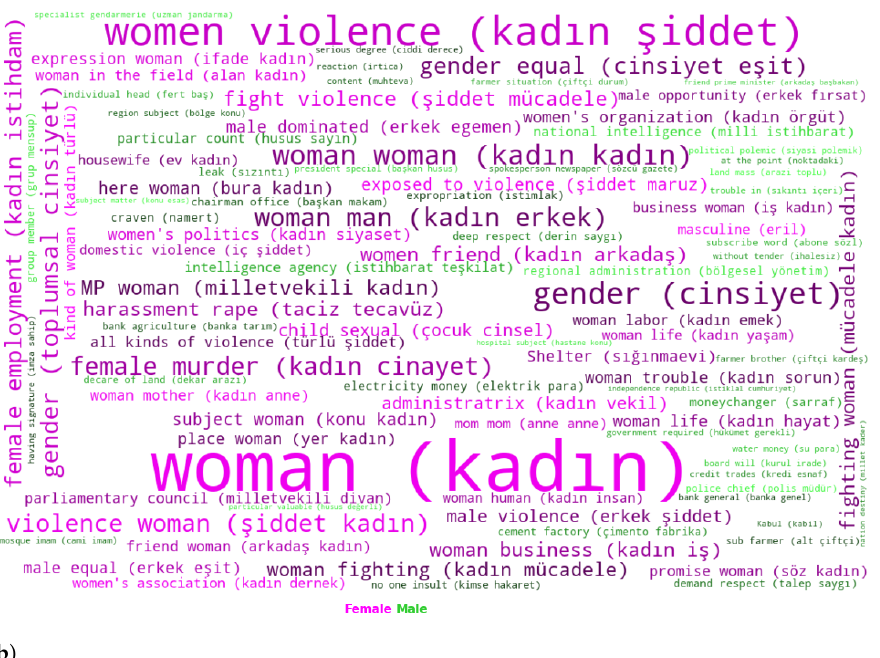
Figure 1. ( a ) Confusion matrix for gender classification with TF-IDF (word and char) _LR. ( b ) Best terms of gender trait of deputies.